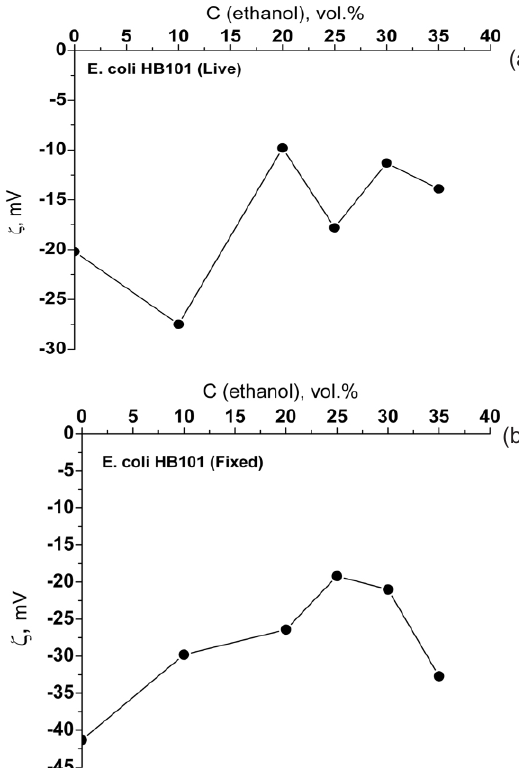
(a) The relative electric polarizability ( g / g ) at low 0 frequencies and the relative zeta-potential ( z / z ) of live 0 E. coli HB101 as functions of the ethanol concentration; g and z are the polarizability g and zeta-potential z at 0 0 0% ethanol: g (live) = 4.1 rel. units, z (live)= - 20.2 mV; 0 0 ∆ C – concentration range of inactivation.(b) The relative in electric polarizability ( g / g ) at low frequencies and the 0 relative zeta-potential ( z / z ) of fixed E. coli HB101 as 0 functions of the ethanol concentration; g and z are 0 0 the polarizability g and zeta-potential z at 0% ethanol: